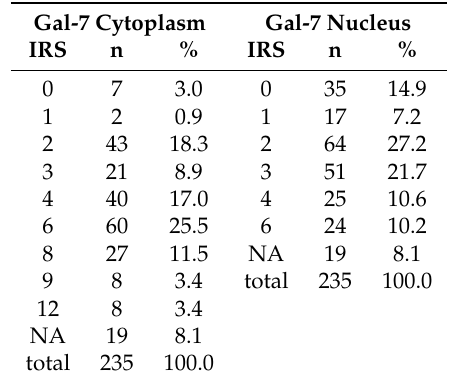
Table 1. Staining results of Gal-7 in the cytoplasm and the nucleus. Gal = galectin; NA = not applicable; IRS = immunoreactivity score.